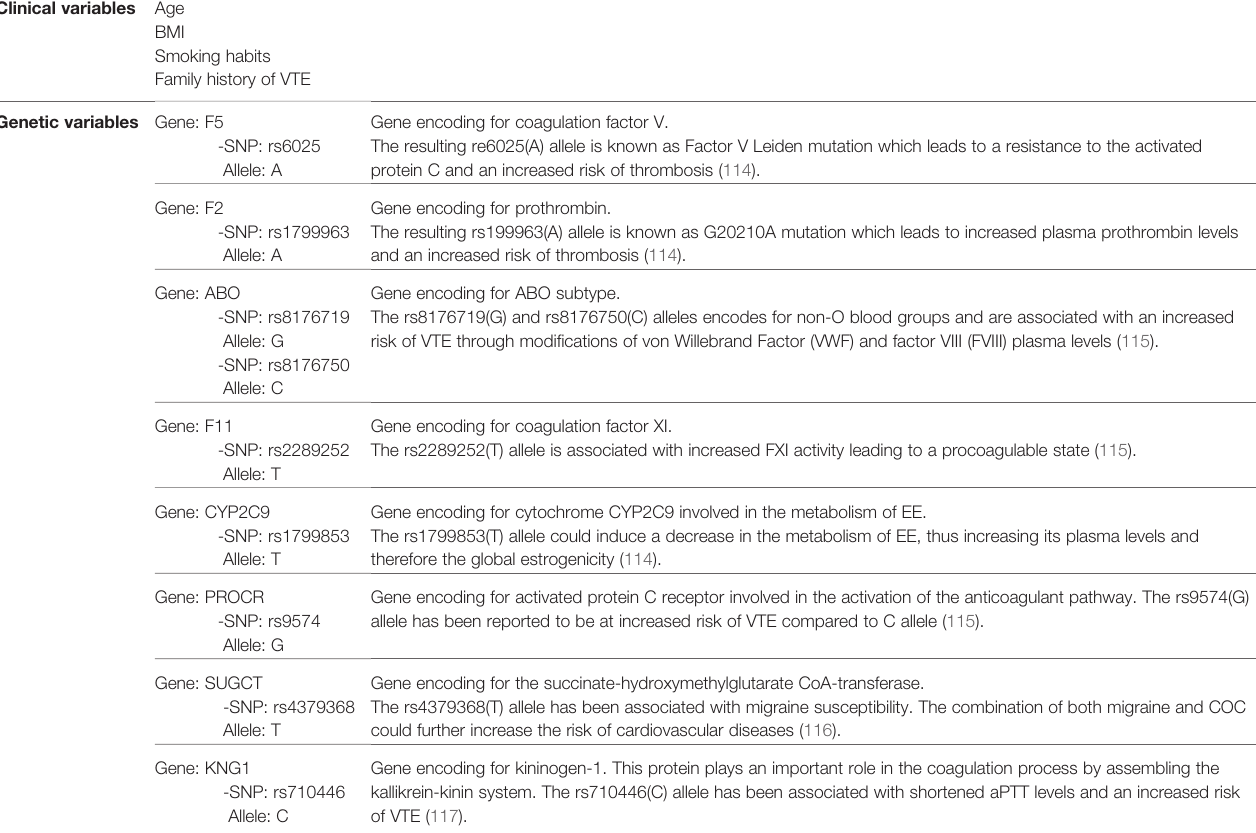
TABLE 5 | Clinical and genetic parameters assessed with the screening test Pill Protect ®